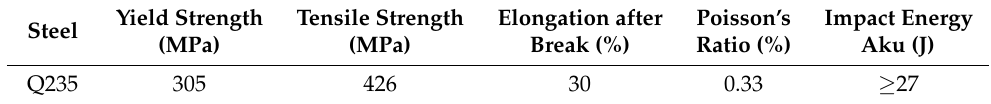
Table 1. Material properties of Q235.